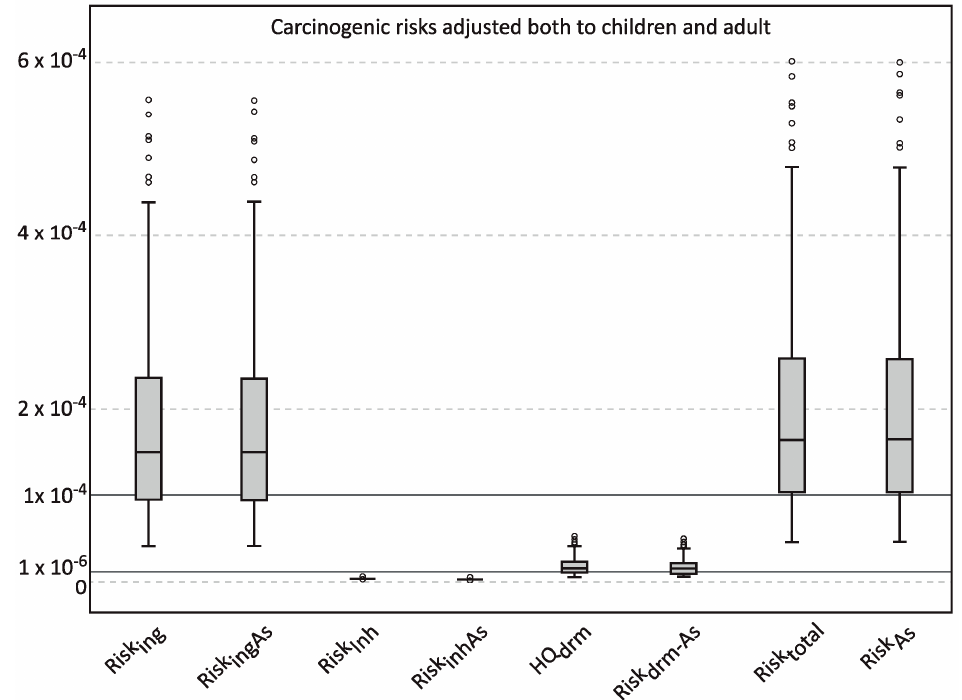
Figure 8. Comparative boxplot distribution of the Carcinogenic Risk adjusted to both children and adult for total PTEs (Ag, As, Cd, Cu, W and Zn) for Ingestion (Risk ing ), Inhalation (Risk inh ), Dermal contact (Risk drm ) routes, the Cumulative Risk (Risk total ) and the Carcinogenic Risk of As for Ingestion (Risk ingAs ), Inhalation (Risk inhAs ), Dermal (Risk drmAs ) routes and the Cumulative Risk (Risk As ) for topsoil samples (tailing samples were removed) of the Panasqueira area. The extremes and outliers were